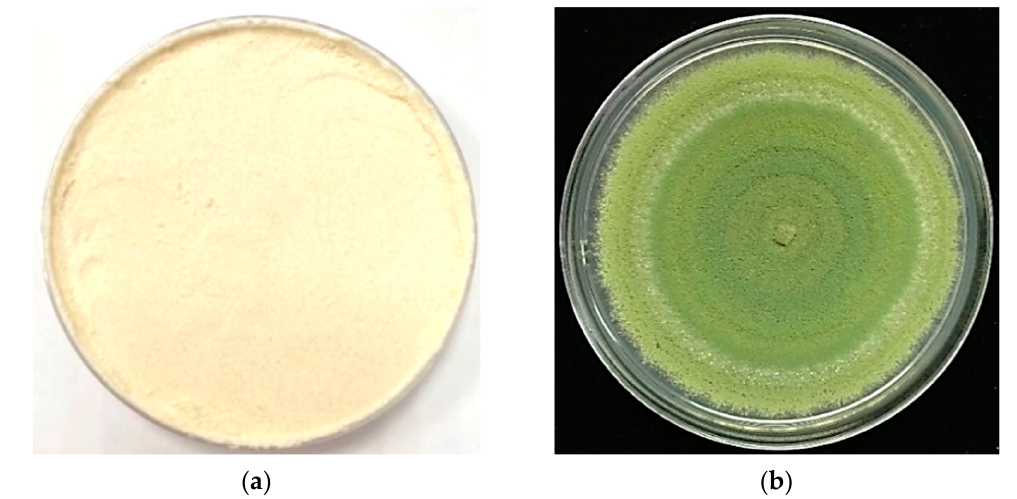
Figure 1. The sample of dielectric properties measurement: ( a ) Rice powder sample; ( b ) Aspergillus sp. BP17.